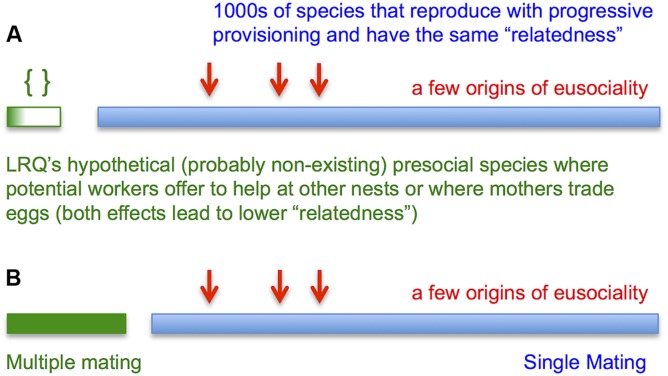
Does “relatedness” cause evolution of eusociality?(a) There are thousands of species that reproduce with progressive provisioning without trading workers or eggs. They all have the same “relatedness.” Yet only a small number of them make a transition to eusociality. The main question is: which ones make the transition and under what conditions? This question was studied by NTW. LRQ’s first model adds that imaginary (and probably non-existing) presocial species with hypothetical trading of workers or eggs are less likely to evolve eusociality. (b) A more meaningful question, not studied by LRQ, would have been whether eusociality is more likely to evolve if the queen mates once or several times [15]. But again a fundamental question here is: what is the condition for the rare emergence of eusociality in species with single mating? This question, never addressed by inclusive fitness theory, was studied by NTW. Since all those species have the same relatedness between mothers and offspring, but only very few of them evolve eusociality, “relatedness” is not the answer.